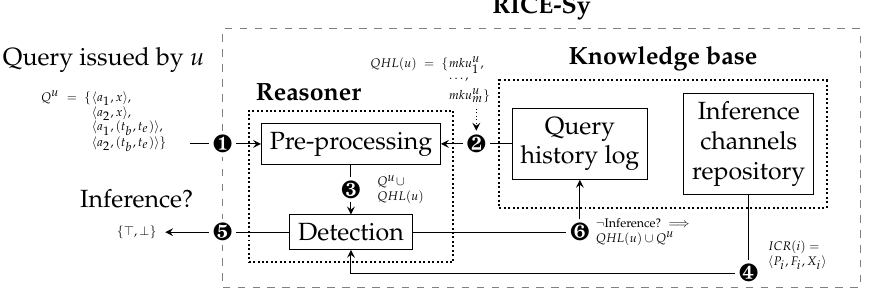
Figure 3. Generic workflow of